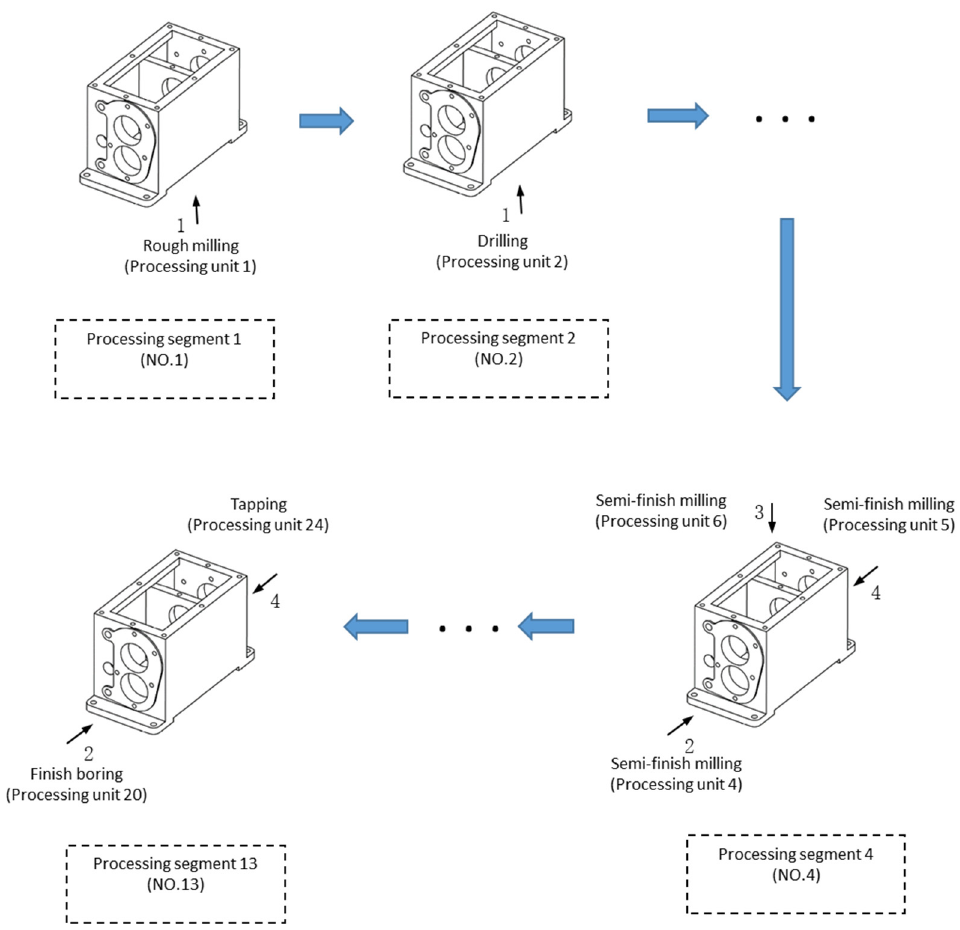
Figure 14. Schematic diagram of the processing information of the processing segments in the plan for part 1.